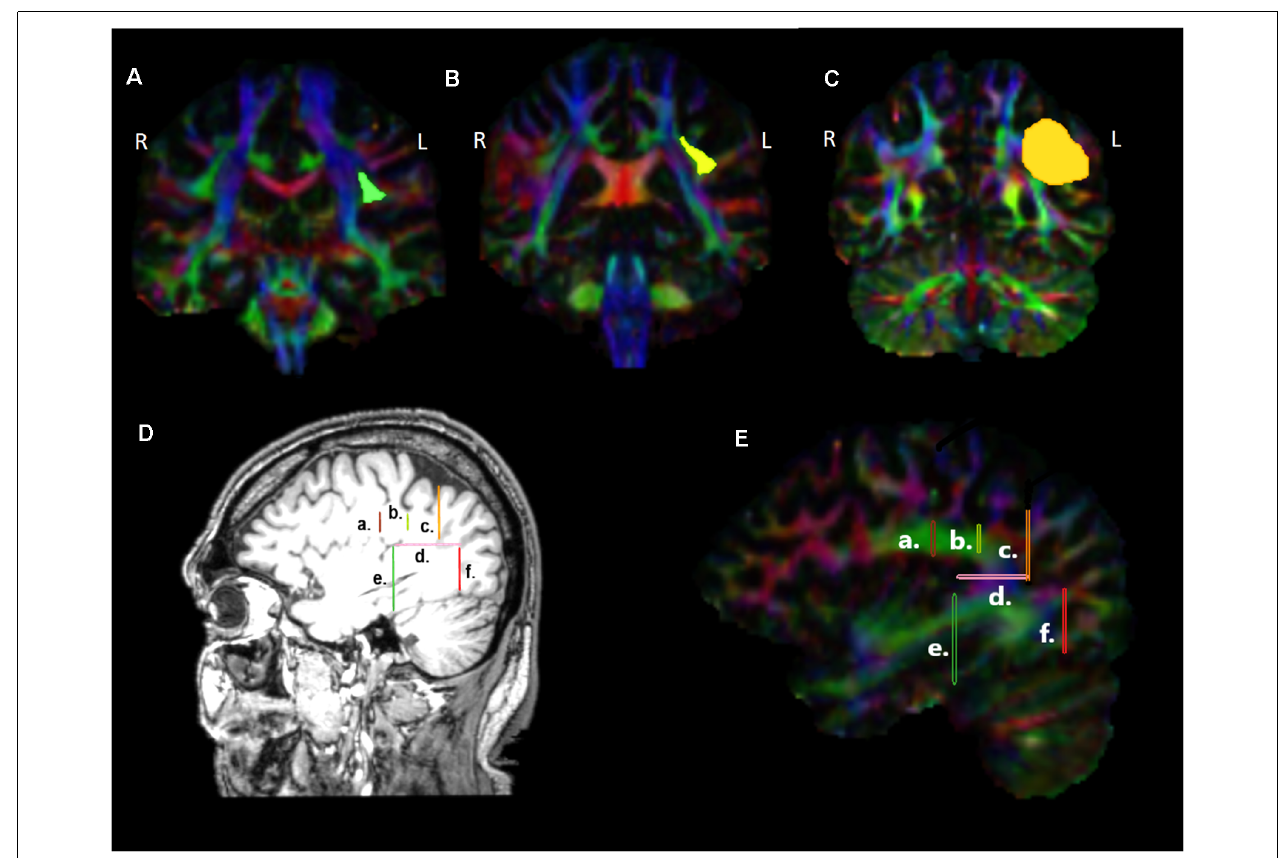
FIGURE 2 | Presentation of the regions of interest (ROIs) used for the reconstruction of the dorsal tracts, namely the arcuate fasciculus (AF), the third (SLF III), and second (SLF II) branches of the superior longitudinal fasciculi in coronal sections (A–C) , at locations indicated in (D) , (E) sagittal sections. a. Location of the first ROI as indicated by the green highlighted region in (A) , b. location of the ROI at the level of the supramarginal gyrus, indicated with yellow in (B) , c. location of the ROI placed immediately before the angular area, indicated with orange in (C) , d. location of the ROI at the temporo-parietal junction, just below the descending posterior ramus of the lateral fissure, e. location of the ROI used for the exclusion of fibers heading towards anterior temporal areas, f. location of the ROI used for the exclusion of fibers heading towards occipital areas. L, left hemisphere; R, right